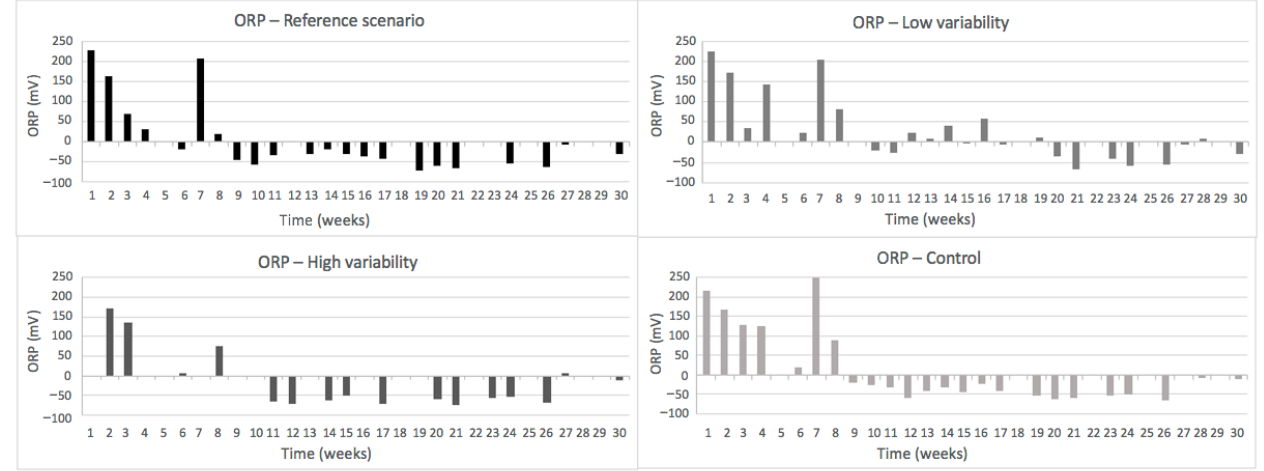
Figure 6. ORP evolution for all tested scenario over the 30 weeks (10 cycles) of the experiment.